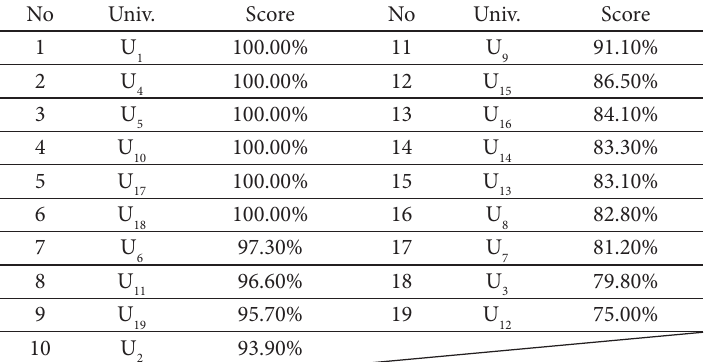
Table 7. Efficiency scores for 19 universities